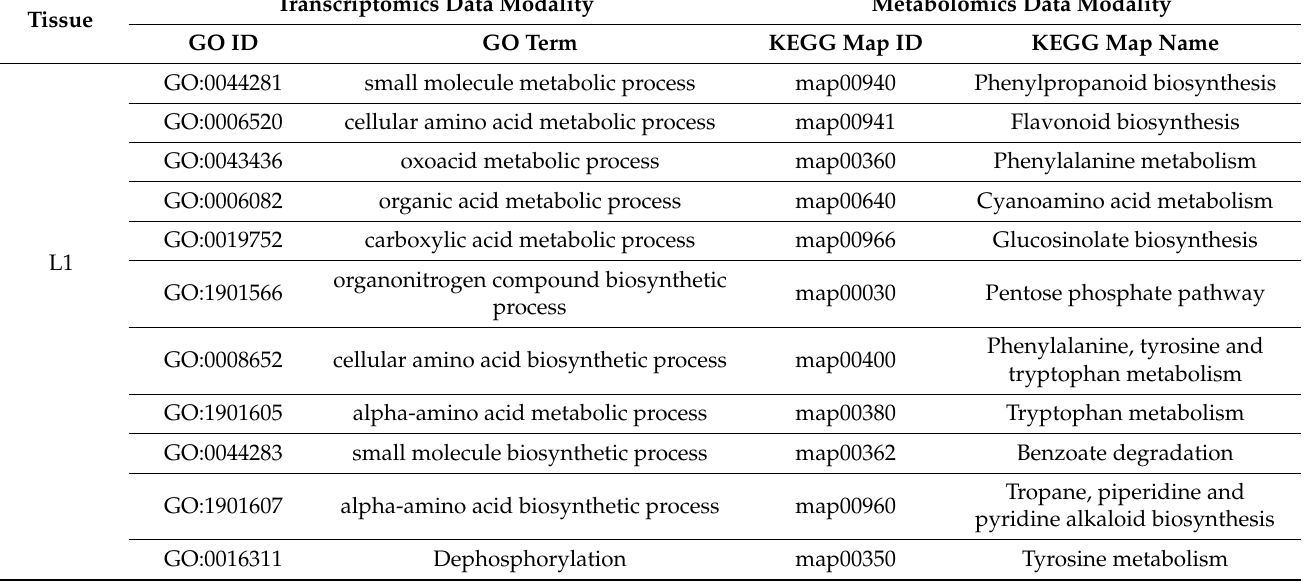
Table 1. An integrative view of the combined output results from MOFA for the leaf +1 (L1), immature (I1), intermediate (I5), and mature internodal (I9) tissues.